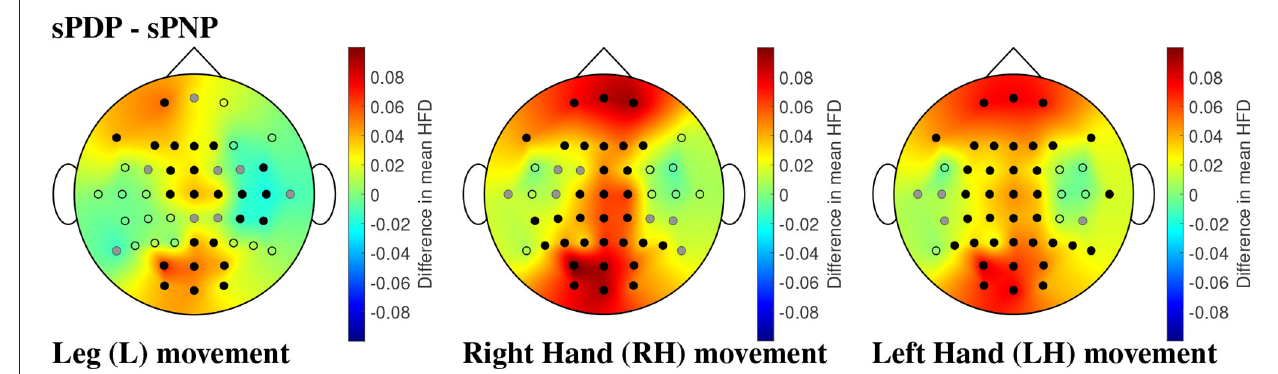
FIGURE 10 | (Dataset 2) Comparisons of mean HFD between participants with subacute SCI that later developed pain (sPDP) and subacute SCI that did not developed pain (sPNP) during MI of L, RH, and LH, in the left, center, and right column, respectively, shown as an example for the time window with 2 s offset. Dots represent the locations of all 48 channels; black dots represent electrodes with statistically significant differences in mean HFD and correction for multiple comparisons, and grey dots represent electrodes with statistically significant differences ( p = 0.05) without correction for multiple comparisons. Spatial distributions demonstrate the difference in mean HFD across groups, where red represents a large positive difference and blue indicates a large negative difference.